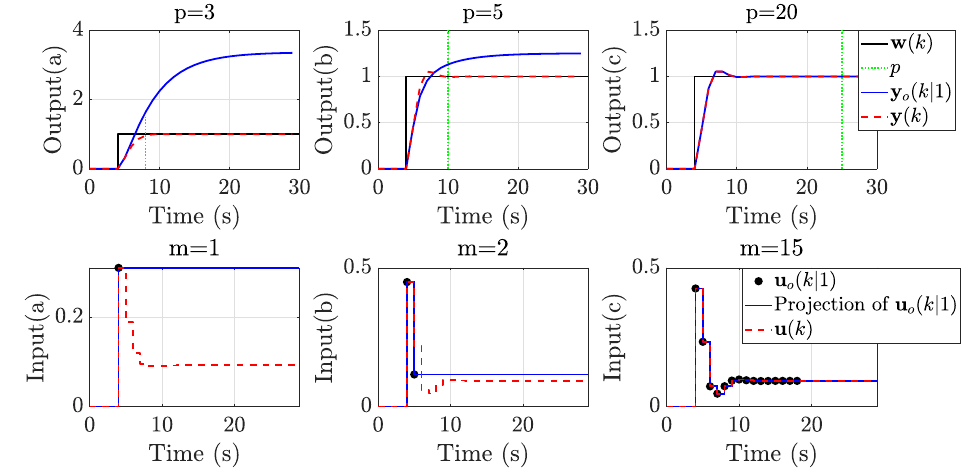
Figure 4. Optimized vs. closed-loop trajectories of the